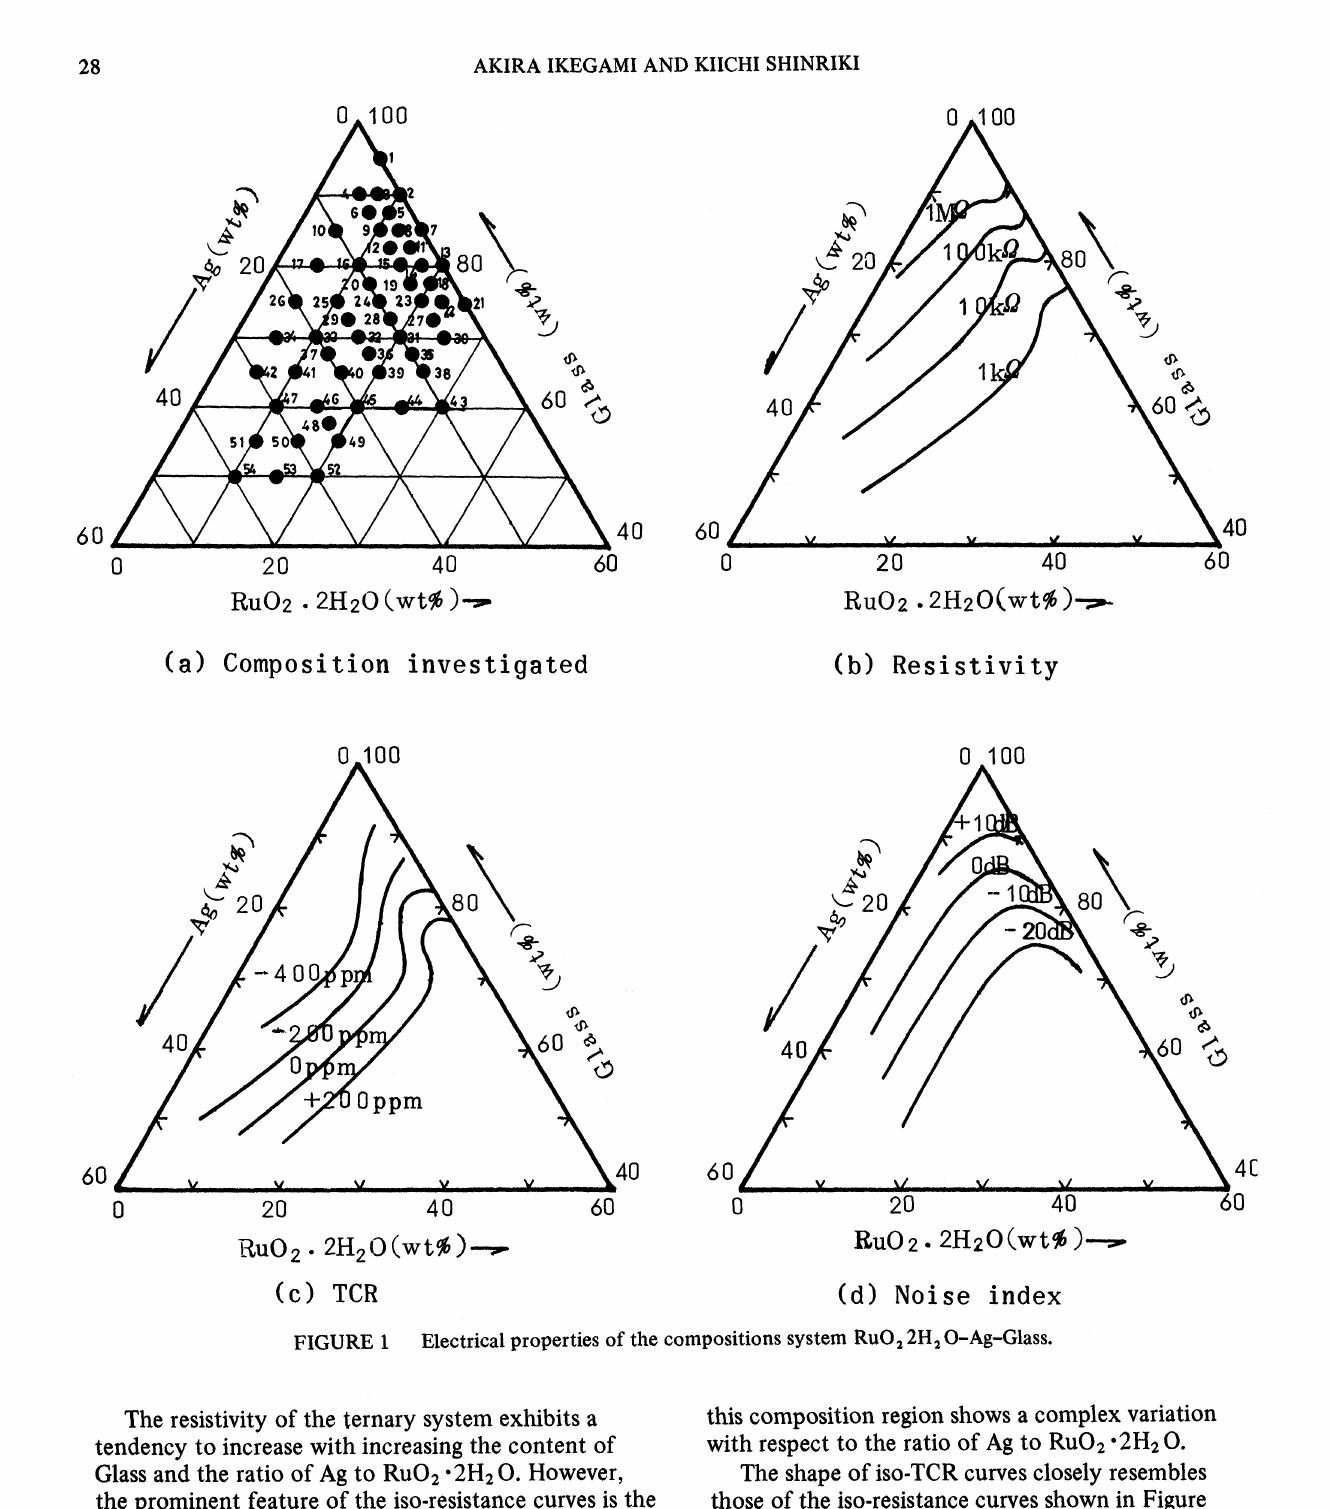
Electrical properties of the compositions system RuO= 2H= O-Ag-Glass.